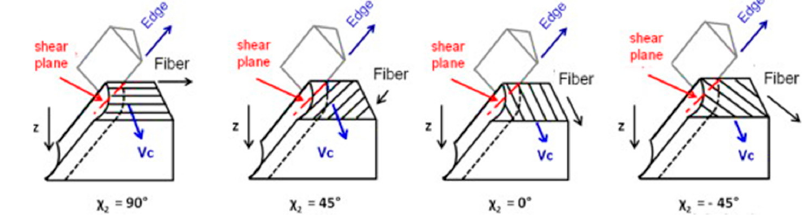
Figure 7. Fiber cutting angle during drilling [28].